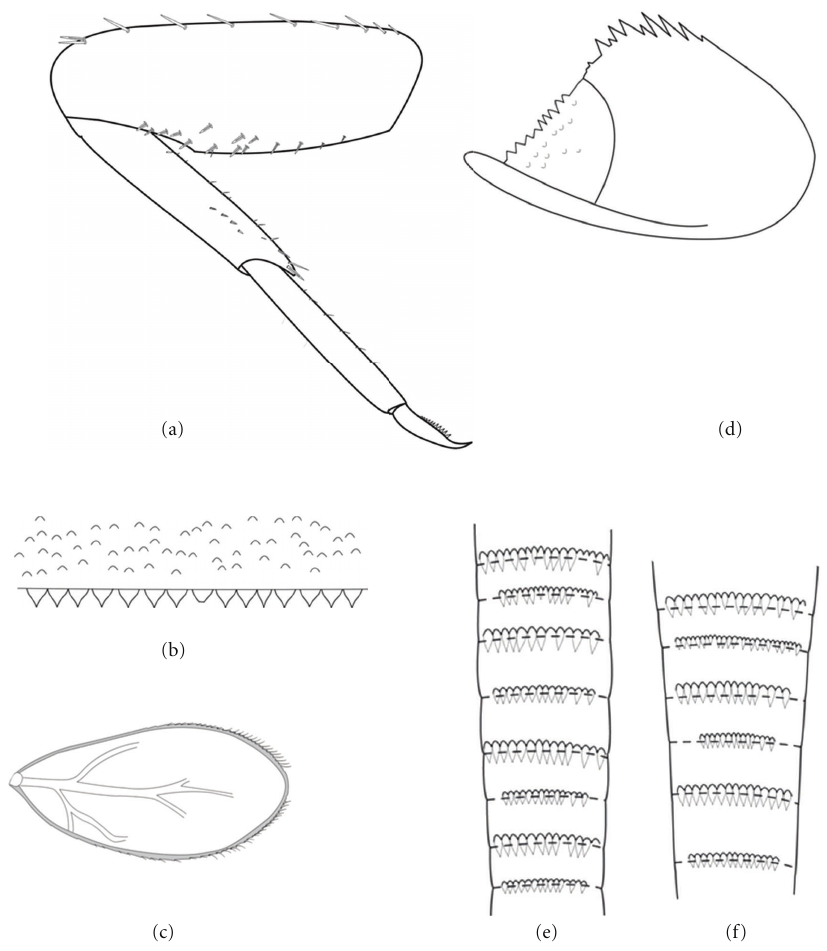
Figure 2: Fallceon sp. V1. (a) fore leg; (b) posterior margin of segment IV; (c) gill IV; (d) paraproct; (e) detail of cercus; (f) detail of terminal